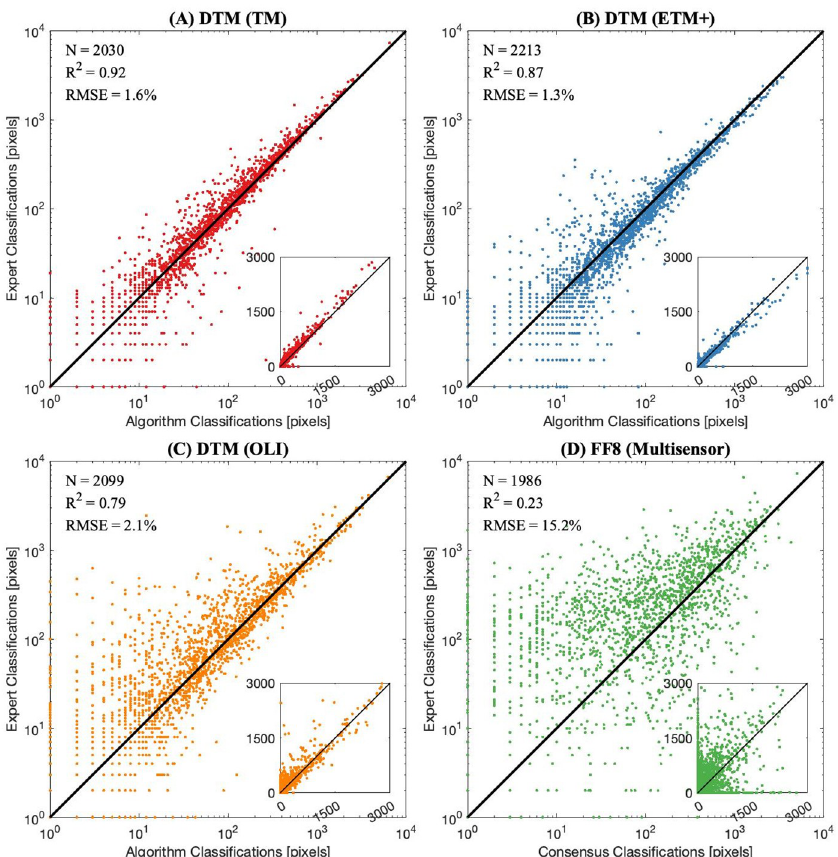
Fig 4. Validation of automated and citizen science kelp classifications. Validation scatterplots for expert (vertical) and automated or citizen science consensus (horizontal) classifications of pixels with kelp present per 1 km of coastline, as follows: (A) validation of TM matchups using DTM; (B) validation of ETM+ matchups using DTM; (C) validation of OLI matchups using DTM; and (D) validation of OLI and TM matchups using